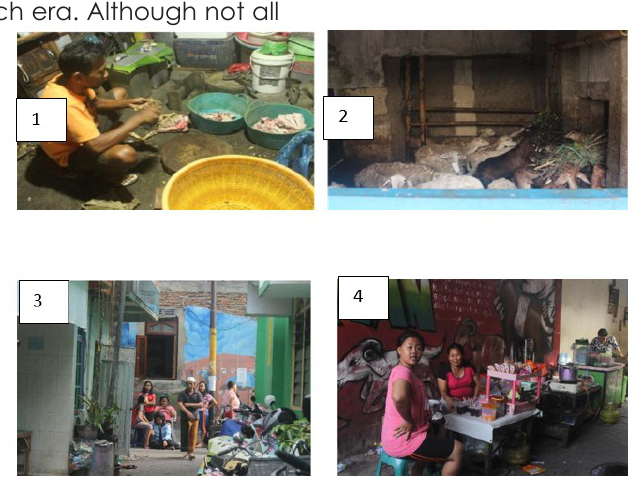
Figure 1. The activity of Bustaman People. 1. Goat Processing, 2. Goat Cage in the village, 3. interaction of inhabitant, 4. Housewife